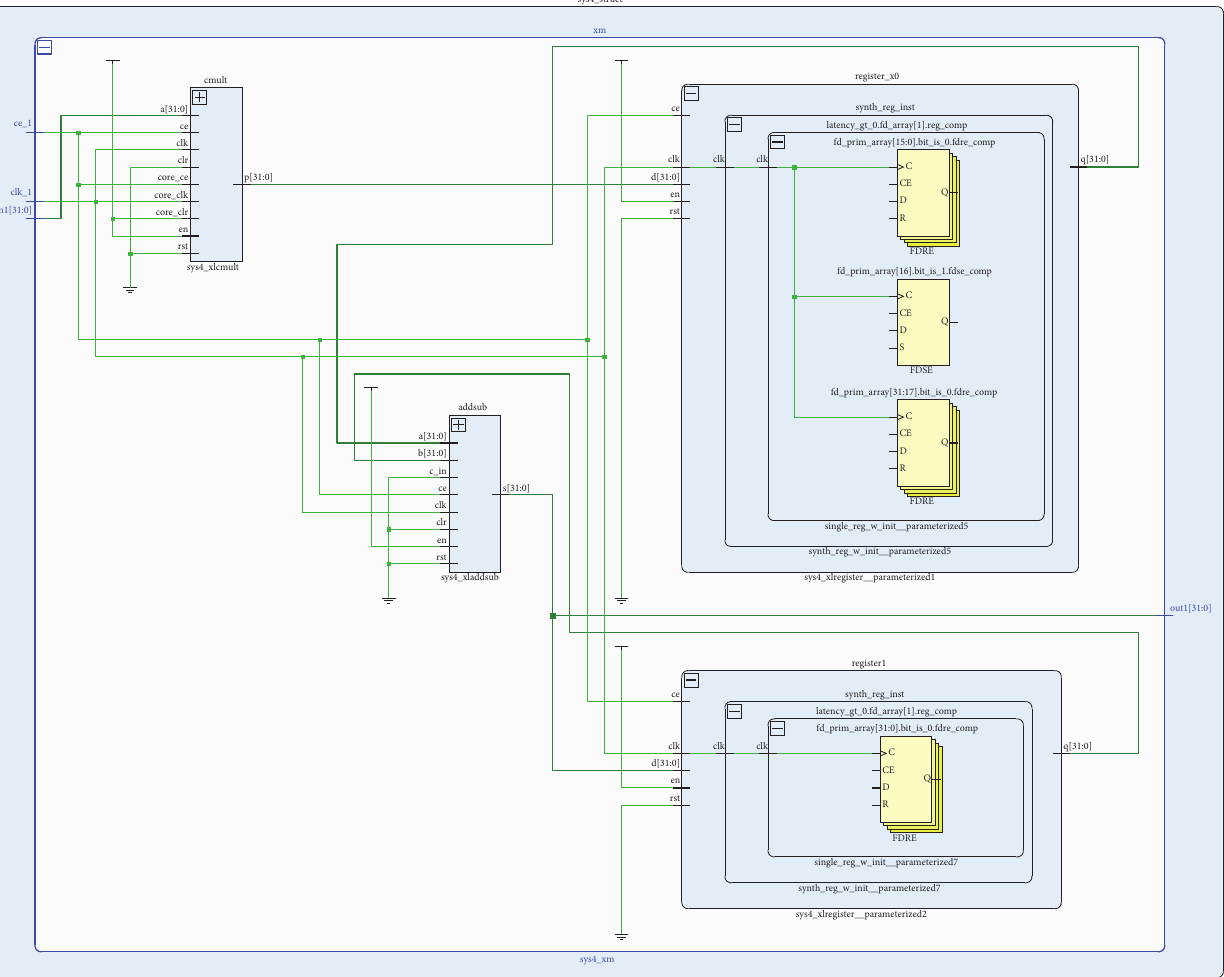
Figure 19: Xilinx schematics of the Fractional order integrator implemented in Kintex 7 (device = 7k160t; package = fbg484 S).